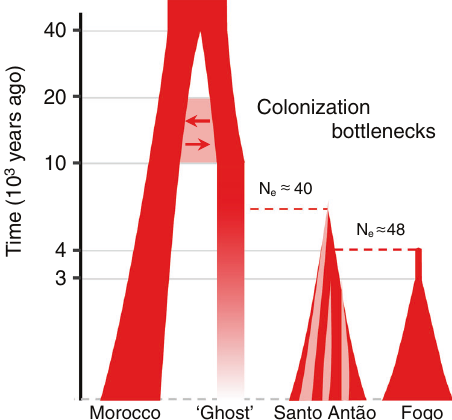
Fig. 3 Schematic of the inferred history of CVI Arabidopsis . N e : effective population size; arrows denote migration. The y-axis is log 10 transformed.